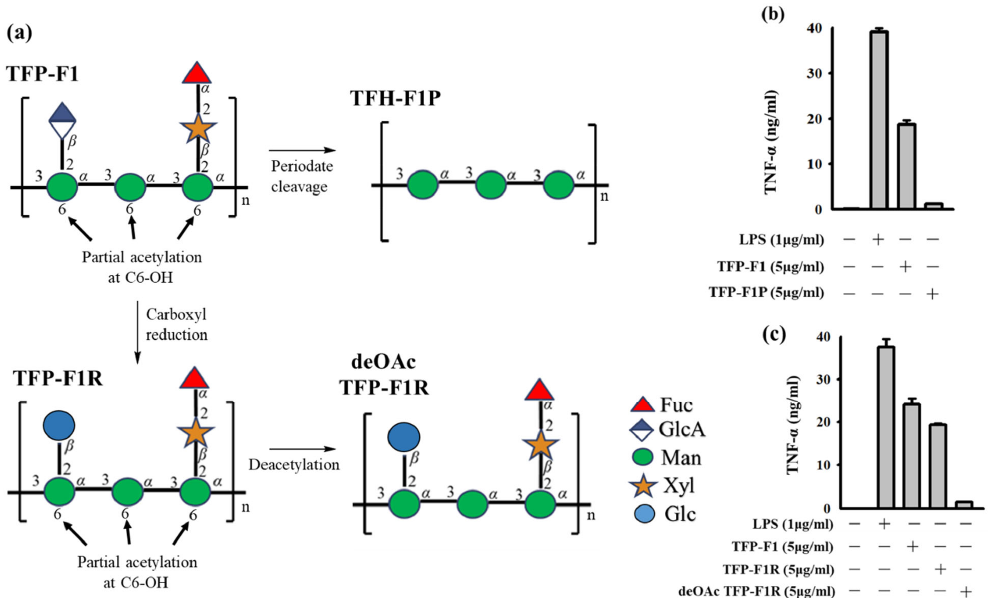
Figure 4. ( a ) Preparation of different TFP-F1 derivatives. TFP-F1R was prepared by treating the TFP-F1 with the CMC and NaBH 4 , while deOAc TFP-F1 was afforded by treating TFP-F1R with NaOH. TFP-F1P was the product of the periodate cleavage of TFP-F1. ( b ) The level of TNF- α was stimulated in the J774A.1 macrophage cells induced by the treatment of TFP-F1 of TFP-F1P. ( c ) The level of TNF- α secreted in the J774A.1 macrophage cells by the treatment of TFP-F1, TFP-F1R, and deOAc TFP-F1R.